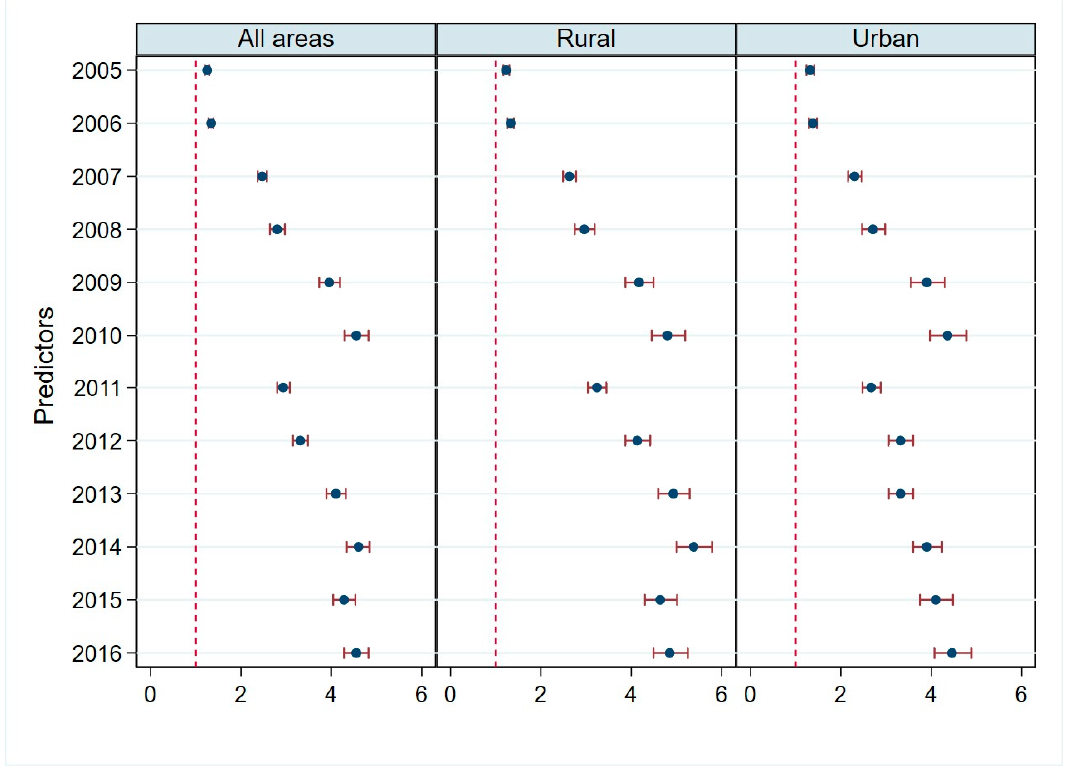
Figure 3. Children’s DTP immunization status in rural and urban areas, 2004–2016. (Notes: Results from multilevel models with 2004 as the reference. Controlled for island of residences, birth attended by a health professional, mother’s age, mother’s educational level, mothers employment status, number of children, household income, and district levels (hospitals / 1000 population, health centers / 1000 population, integrated health services / 1000 population, doctors / 1000 population, other health workers / 1000 population). Reported are odds ratios (95% confidence intervals)).